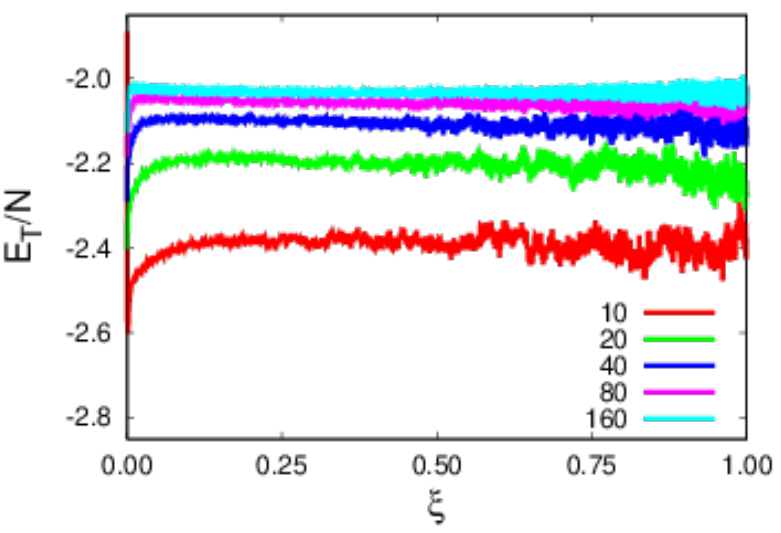
Figure 8. Plots of the total polymer energy per monomer, in terms of ξ for polymers of various